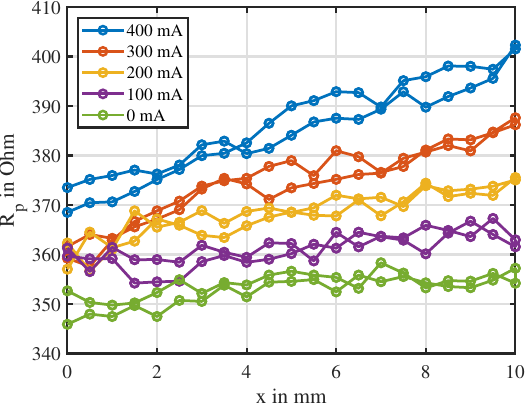
Figure 14. Characteristic of the parallel resistance over the position at different fixed currents. Measurement points are indicated by dotted